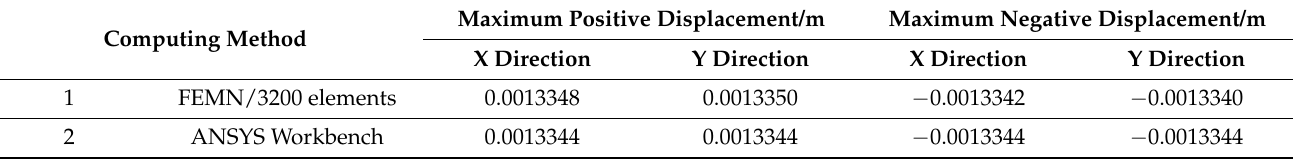
Table 8. Comparison of maximum positive and negative displacements of the